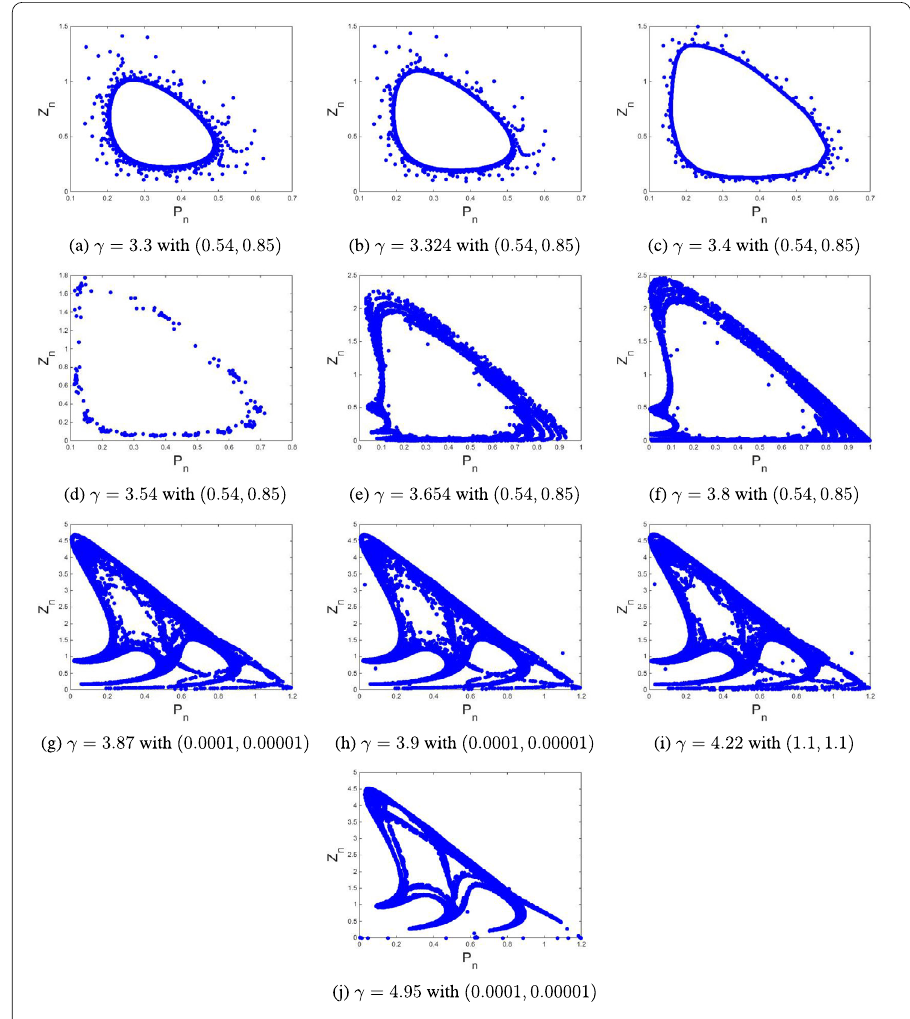
Figure 2 Attracting invariant closed curves of phytoplankton–zooplankton model (8)